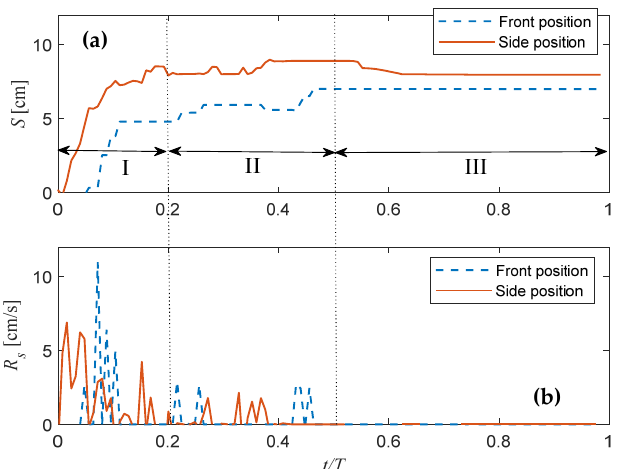
Figure 12. Temporal development of ( a ) scour depth and ( b ) scour rate at the front and side positions of the structure.